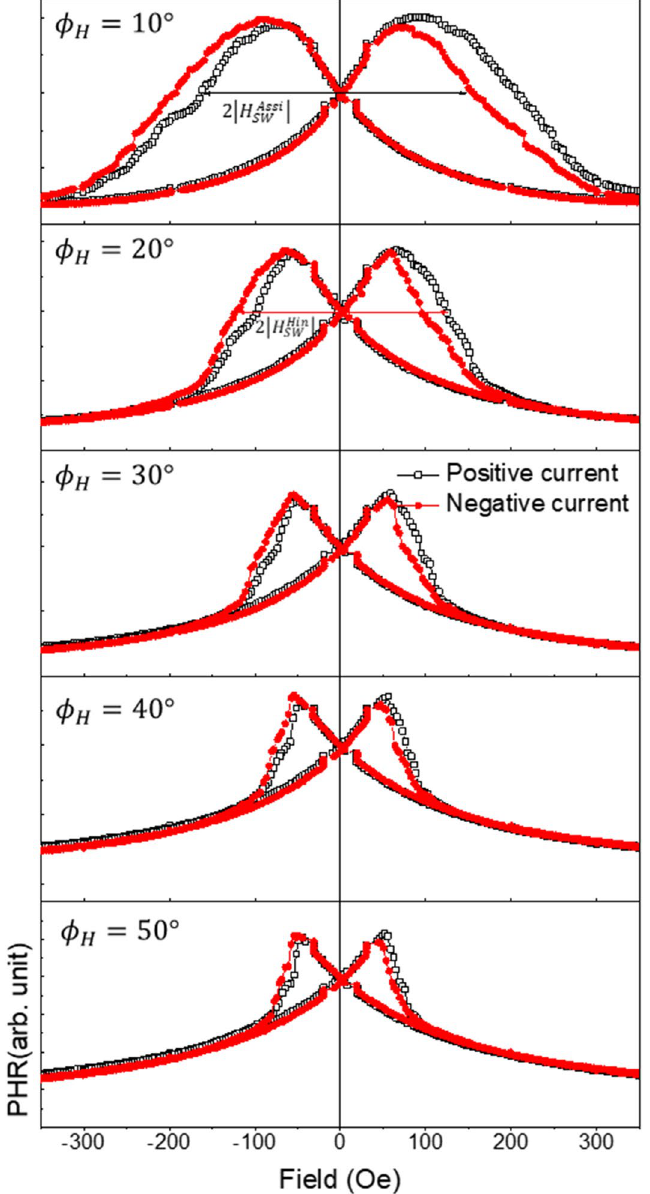
Figure 3. PHR data measured at 3 K with a current density of 2.5 × 10 5 A/cm 2 , during magnetization reversal by field scan at different field directions ϕ H . Black open and red solid symbols represent data measured when the current is positive and negative, respectively. The switching fields for and are marked, respectively, with black and red